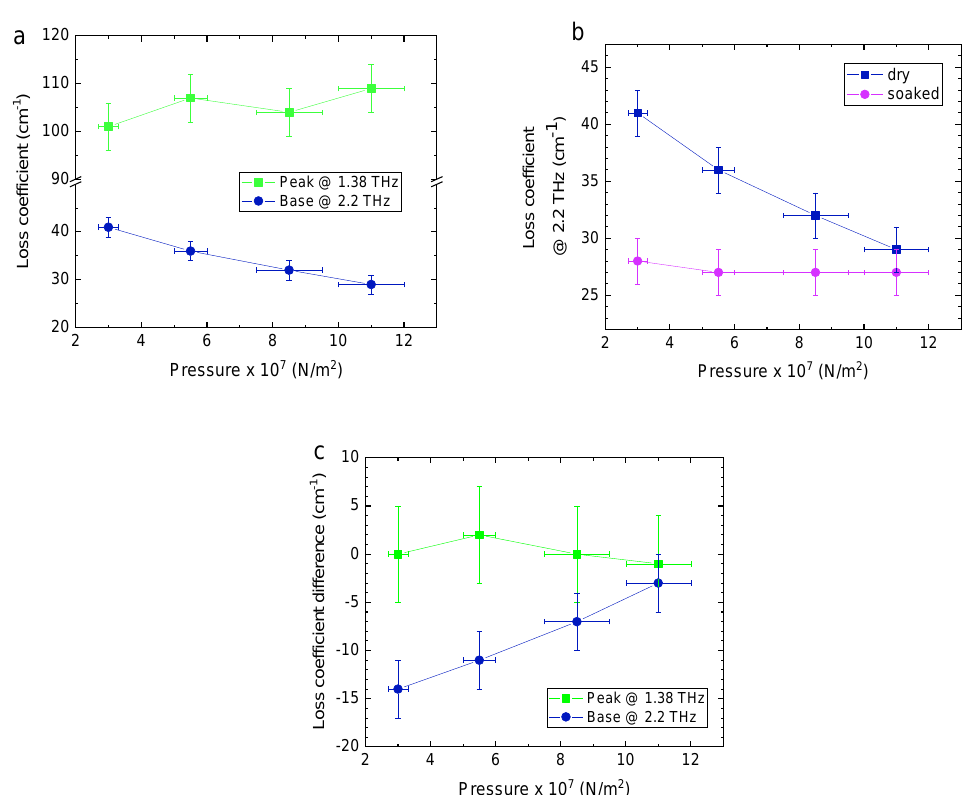
Figure 6. ( a ) Loss coe ffi cients of dry pellets at the absorption peak @ 1.38 THz and away from absorption @ 2.2 THz, as a function of pressure. The errors in the loss are the standard deviation of four pellet samples. ( b ) The loss coe ffi cients of dry and soaked pellets @ 2.2 THz as a function of pressure. ( c )